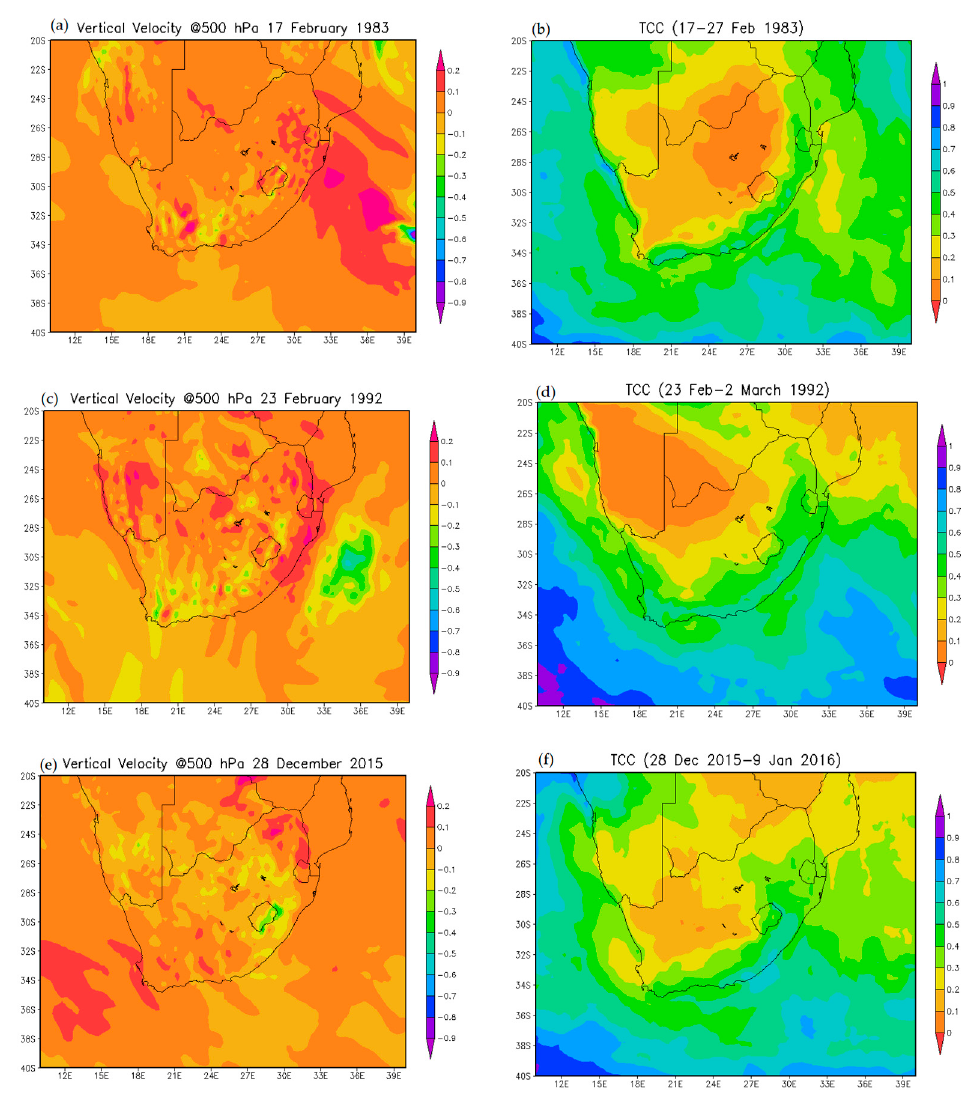
Figure 11. Vertical velocity (Pa/s) at 500 hPa for the ( a ) 17–27 February 1983 HW, ( b ) 23 February 1991 to 2 March 1992 HW, and ( c ) 28 December 2015–9 January 2016 HW; and total cloud cover (TCC) for the ( d ) 17–27 February 1983 HW, ( e ) 1991 to 2 March 1992 HW, and ( f ) 28 December 2015–9 January 2016